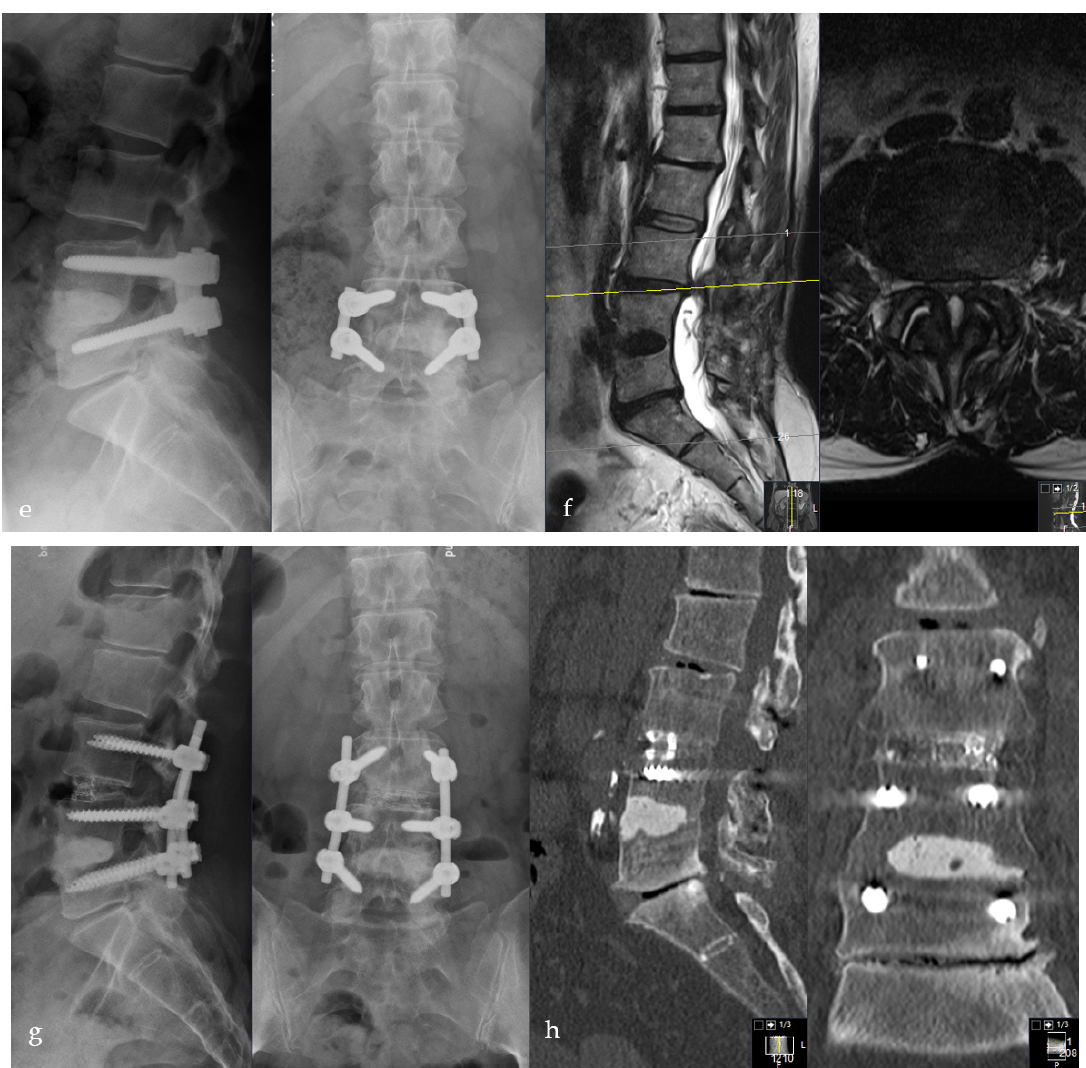
Figure 5. Female patient, 46-years old, pyogenic erosive spondylodiscitis L4/5 with staphylococcus aureus identified as the causative pathogen. Preoperative standing a.p. and lateral X-ray ( a ), MRI of the lumbar spine ( b ), and CT scan ( c ). Postoperative standing a.p. and lateral X-ray after Cement-PLIF L4/5 and postero-lateral fusion ( d ). Six-year follow-up with standing X-rays a.p. and lateral of the lumbar spine ( e ). Cranial adjacent segment disease (L3/4) is demonstrated by MRI ( f ). Adjacent segment fixation L3/4 after preoperative exclusion of reinfection by open biopsy with postoperative standing X-rays of the lumbar spine six years post-operatively ( g ). Sixteen-year follow-up CT scan of the lumbar spine with intact Cement-PLIF, anterior and posterior fusion, and infection elimination ( h ). We saw two patients (2/73; 2.7%) with an anterior leakage of PMMA in the